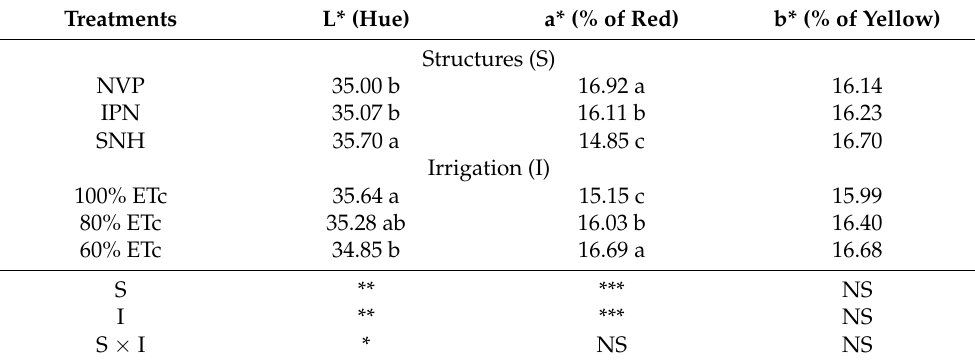
Table 7. Effect of structures and irrigation levels on fruit color of tomato fruit (in 2020).